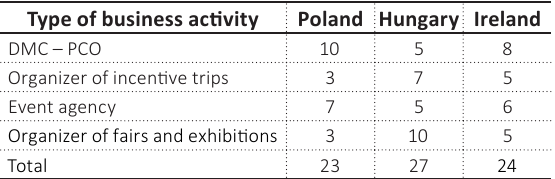
Table 3. Type of business activity– employees